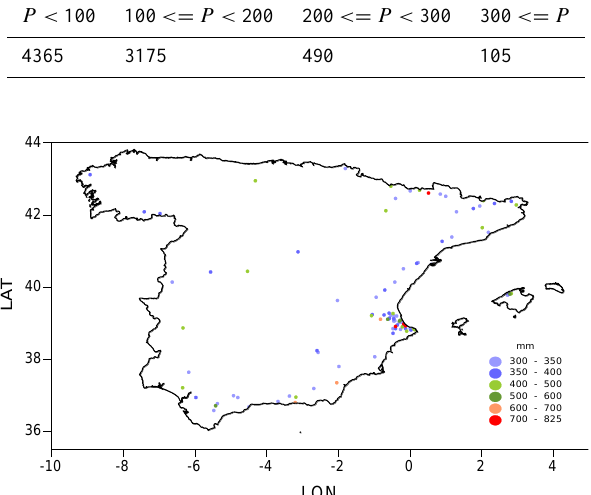
Fig. 4. Location of rain gauges with maximum registered daily Figure 4.- Location of rain gauges with maximum registered daily precipitations greater than 300 mm. Colors indicate precipitations greater than 300mm. Colors indicate precipitation precipitation amounts according the scale. amounts according to the